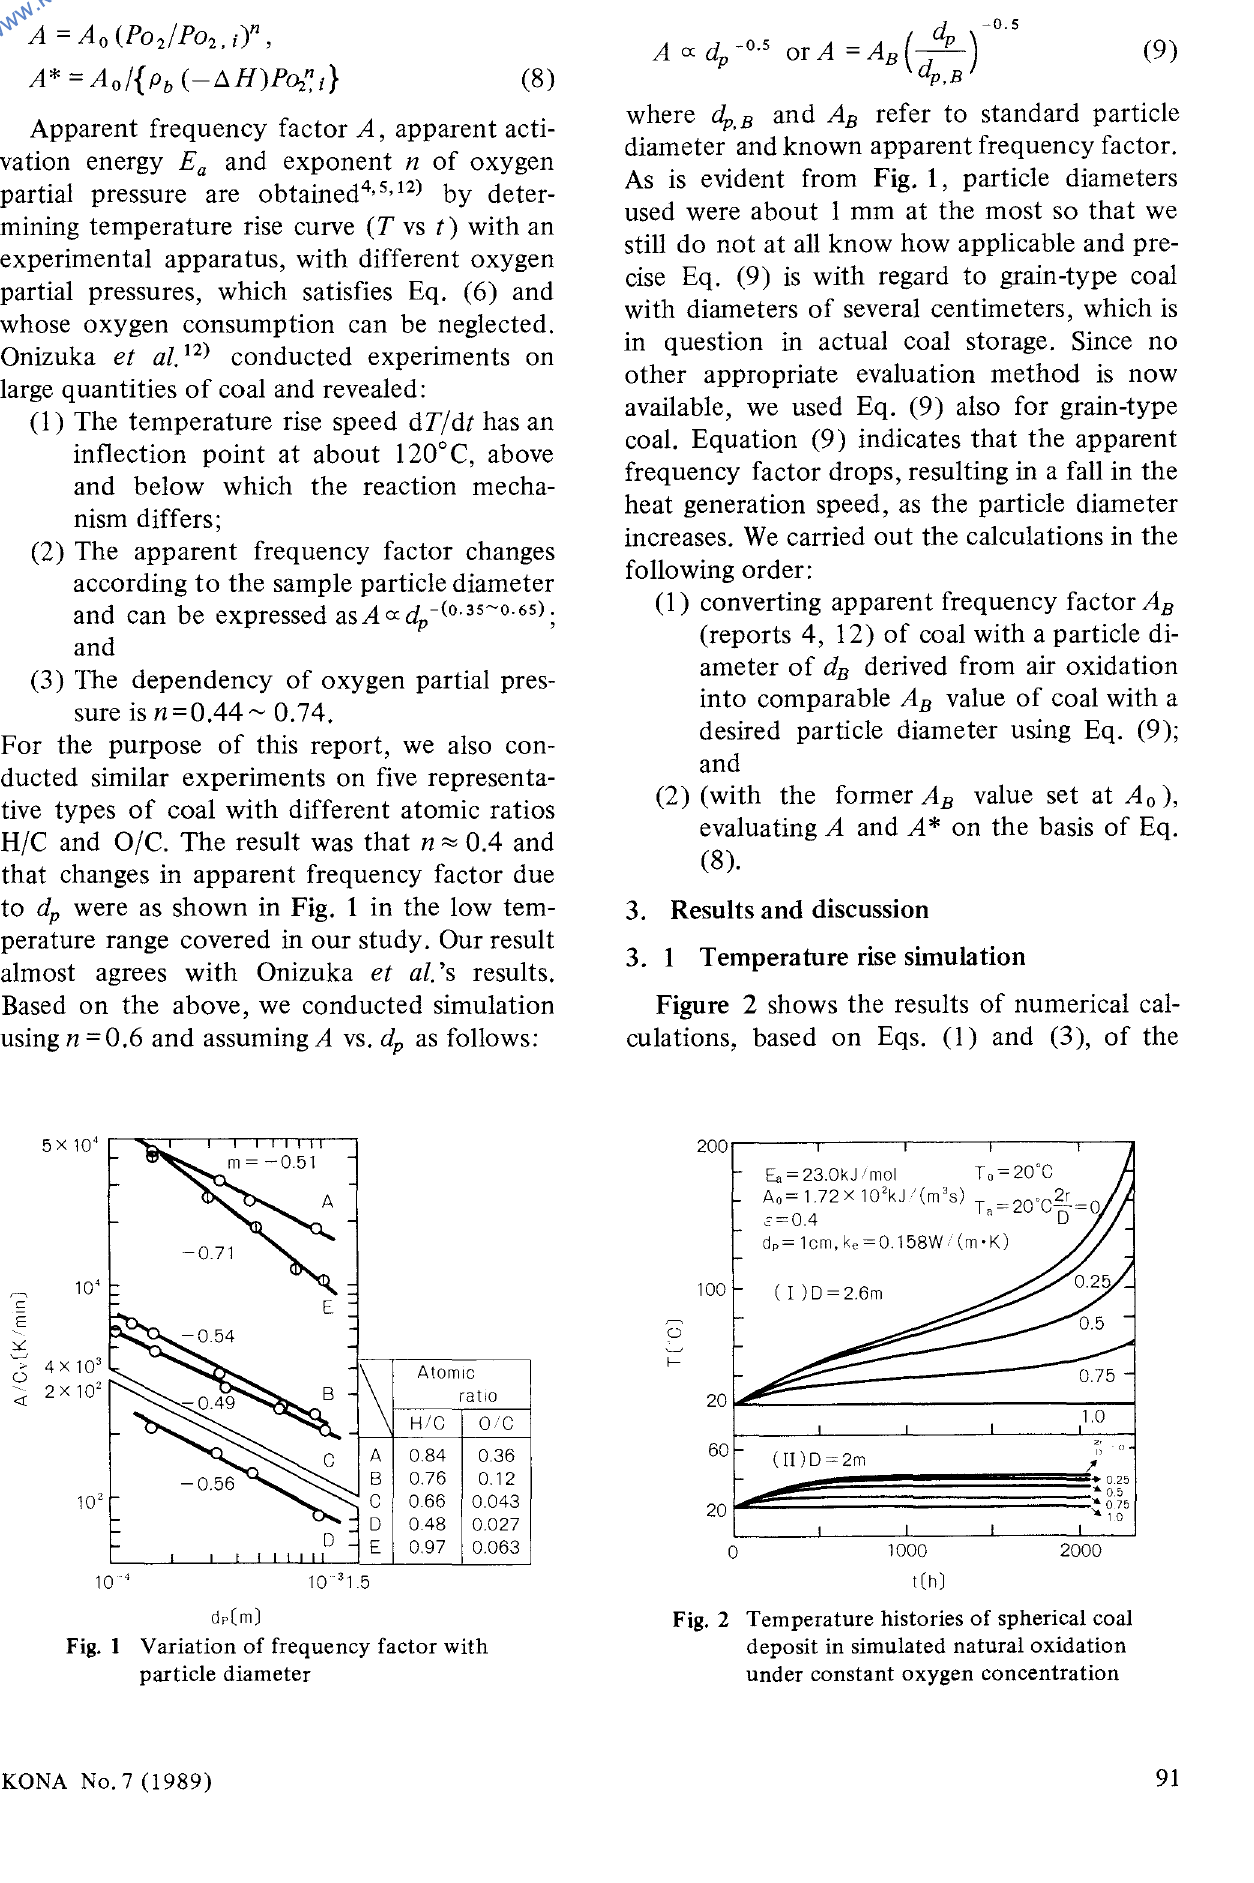
Fig. 2 Temperature histories of spherical coal deposit in simulated natural oxidation under constant oxygen